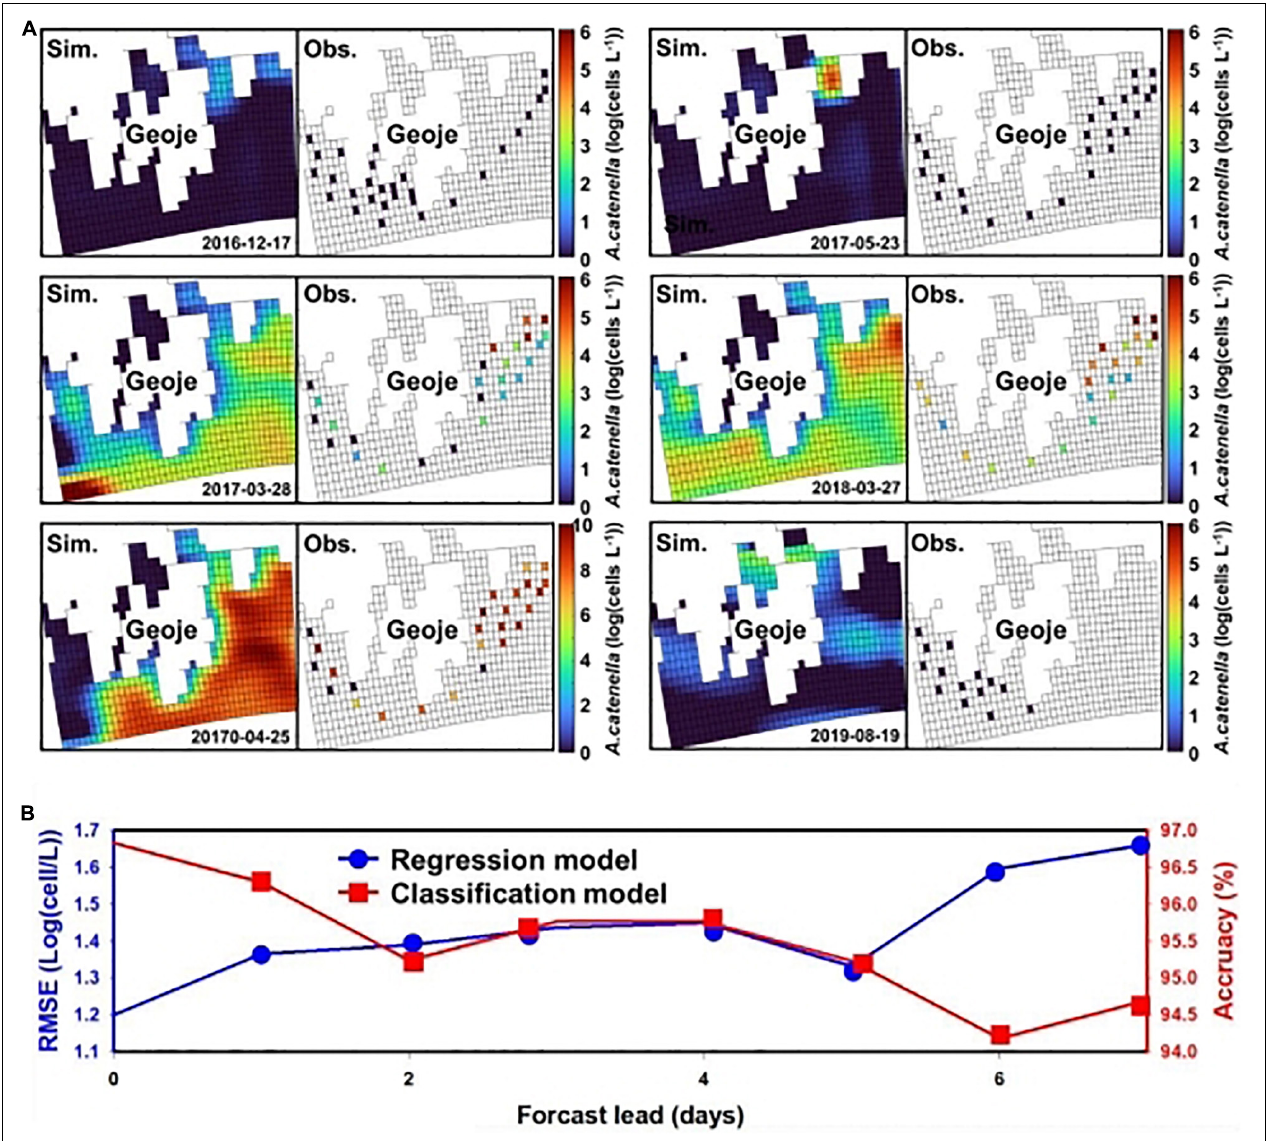
FIGURE 5 | Spatial distribution of A. catenella and forecast performance with lead time— (A) spatial distribution of A. catenella on December 17, 2016, March 28, 2017, April 25, 2017, May 23, 2017, March 27, 2018, and August 19, 2019; (B) A. catenella forecast performance with lead time. In (A) , the left and right figures indicate the simulated and observed distributions of A. catenella , respectively. The color range indicates the density variation in A. catenella from the lowest (blue) to the highest (red) value. The spatial distributions were generated using GoogleNet and ResNet 101. In (B) , the blue and red curves indicate the performance of regression and classification CNN models, respectively. The x and y (left and right) axes denote the forecast lead time (days), root-mean-square error (RMSE) of the regression model, and accuracy of the classification model, respectively. The model with lower RMSE is considered for regression while that with higher accuracy is selected for